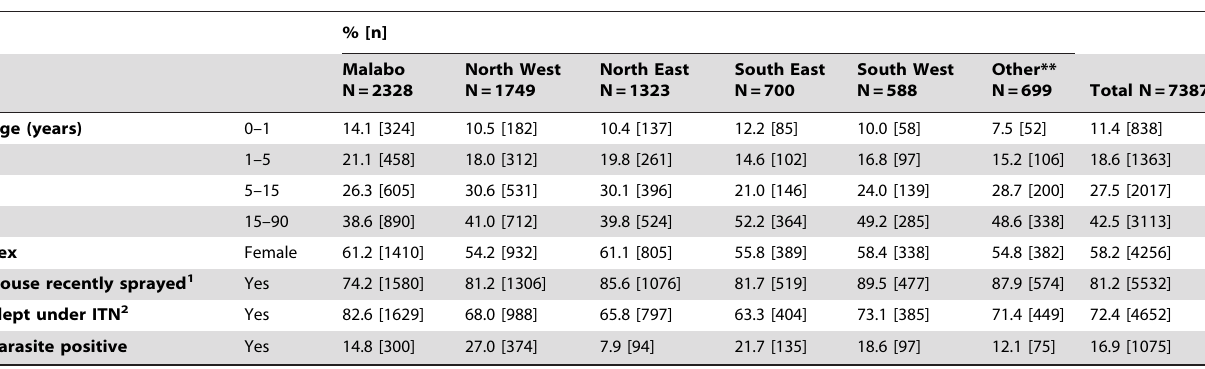
Table 1. Demographic characteristics of the study